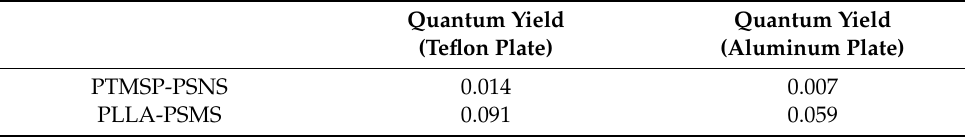
Table 1. Quantum yields of PTMSP-PSNS and